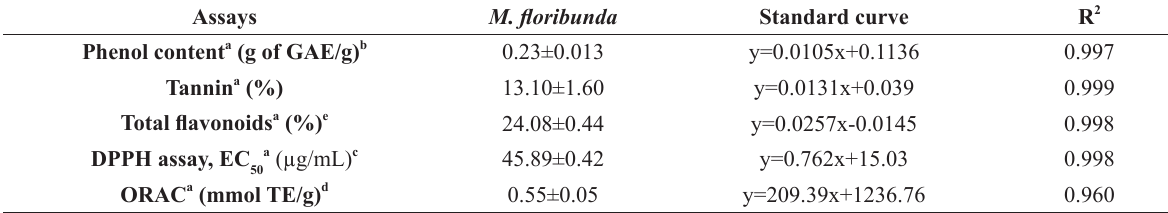
Total phenolic, flavonoid and tannin contents and antioxidant capacity by the DPPH and ORAC assays of the ethyl acetate extract from the leaves of Myrciaria